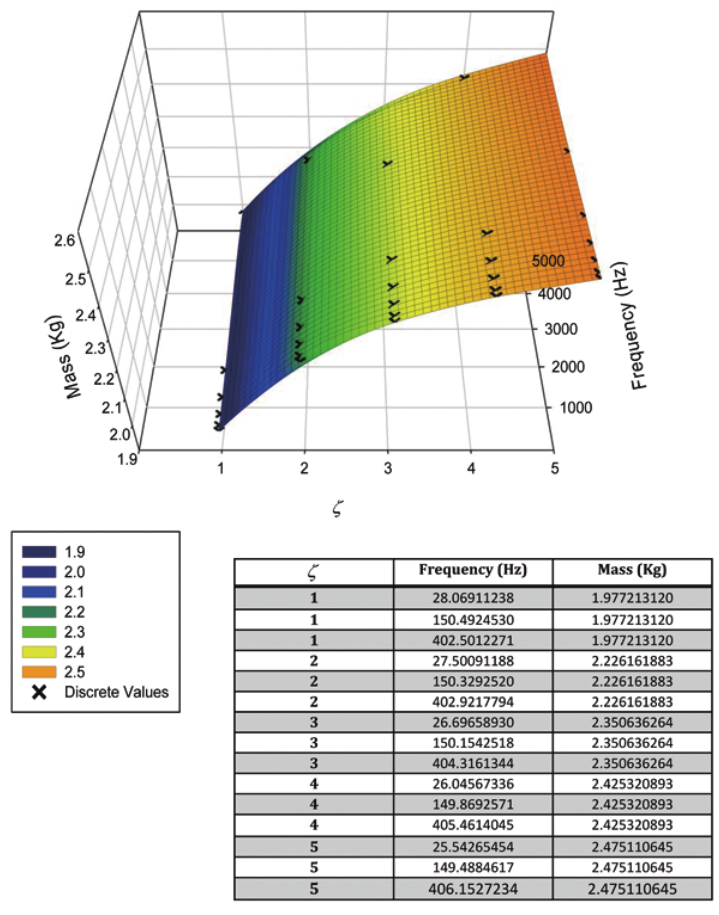
Fig. 3. Mass and frequency variation as a function of ζ for ZrO 2 –